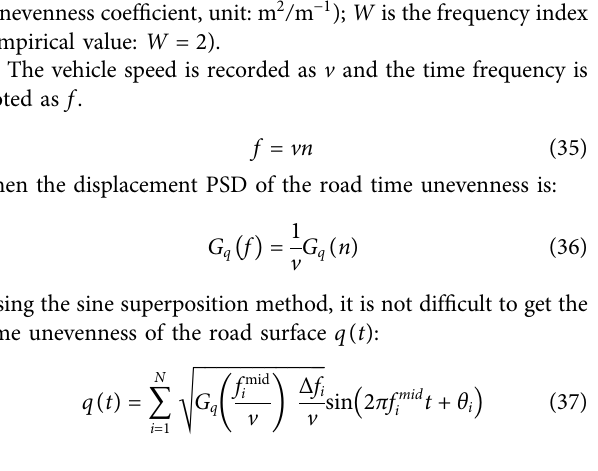
Frontiers in Materials |